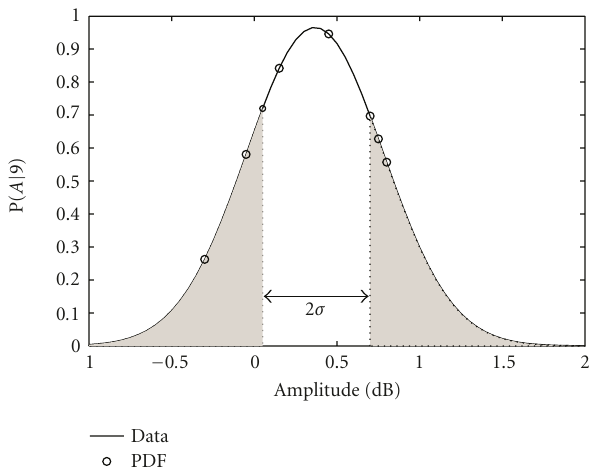
Figure 20: The measured coupler amplitude imbalance fitted a Gaussian probability density function, σ A = 0.4131 dB, μ A = 0.366 dB.